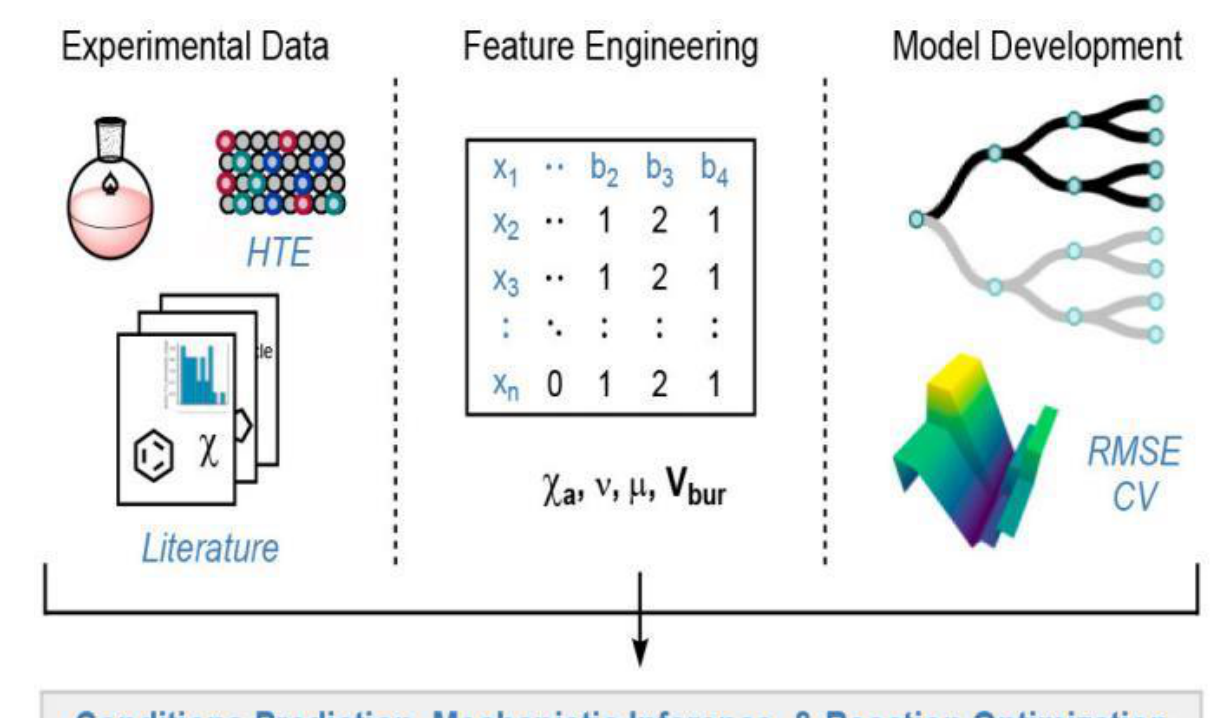
Figure 7. The AI-assisted reaction yield prediction. Reproduced with permission from [Żurański, A.M.; Alvarado, J.I.M.; Shields, B.J.;et al], [Predicting Reaction Yields via Supervised Learning]; pub- lished by [Acc. Chem. Res], [2021].